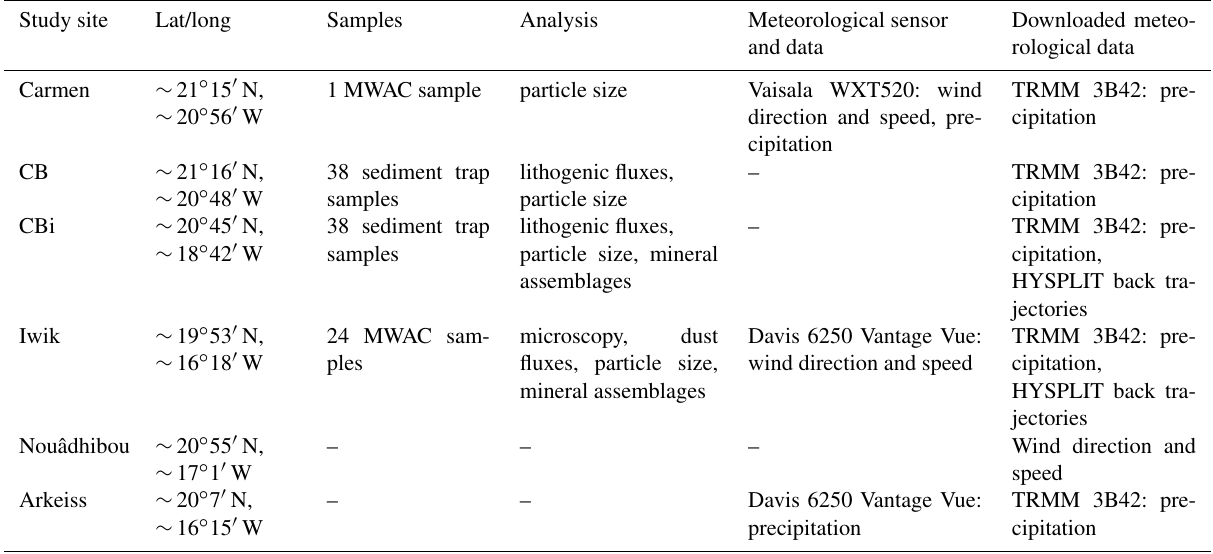
Table 1. Overview of the material and methods employed at each study site.